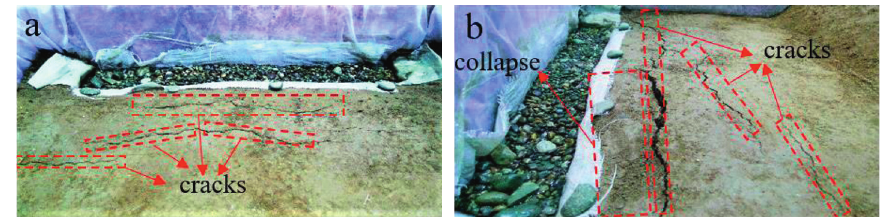
Figure 7: Collapse and crack after permeation. (a) 10 hours. (b) 30 hours.